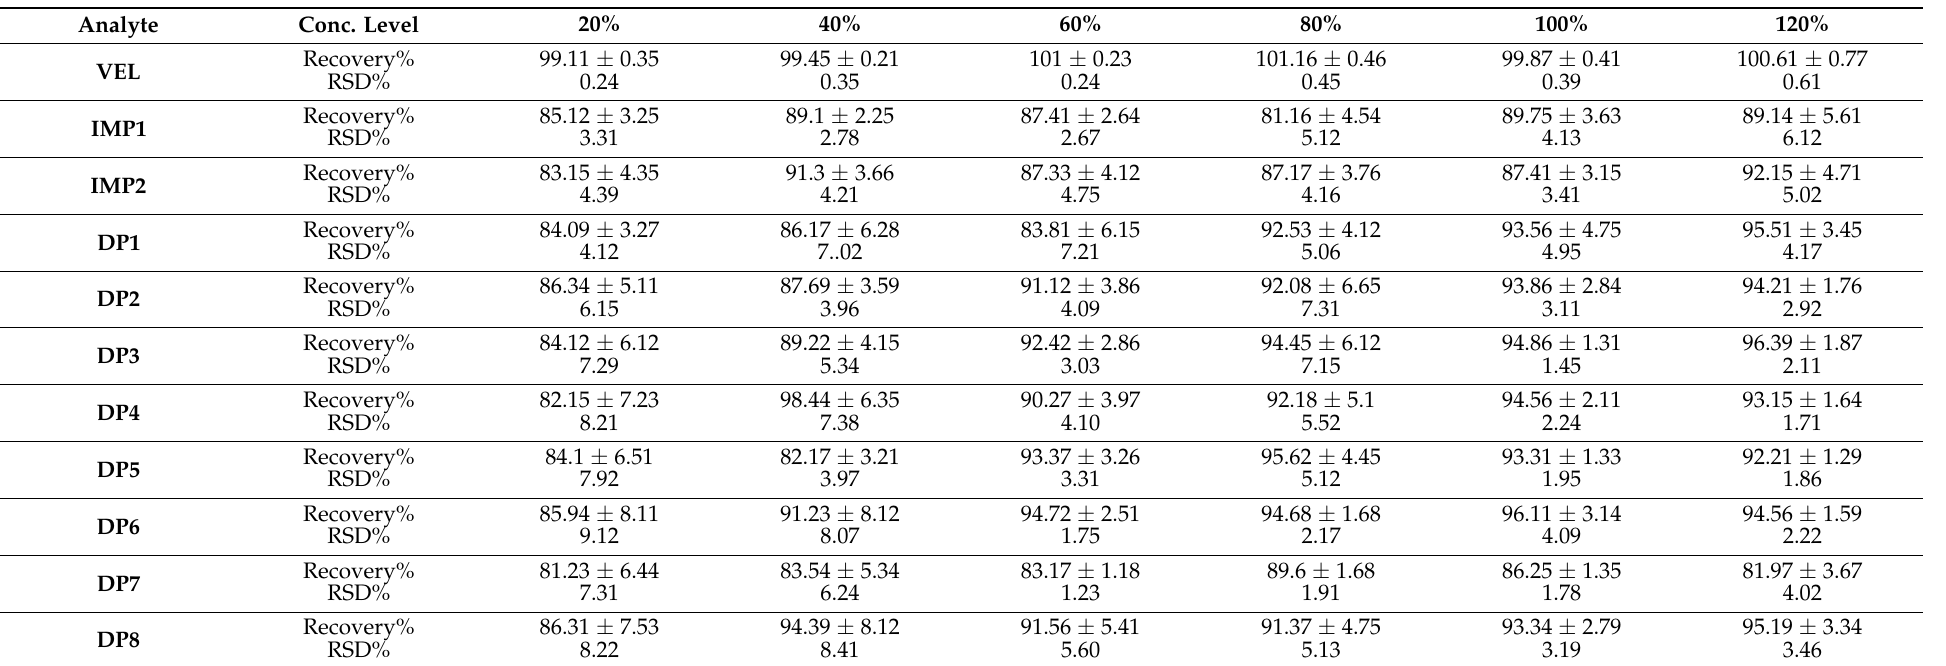
Table 2. Results of Recovery and